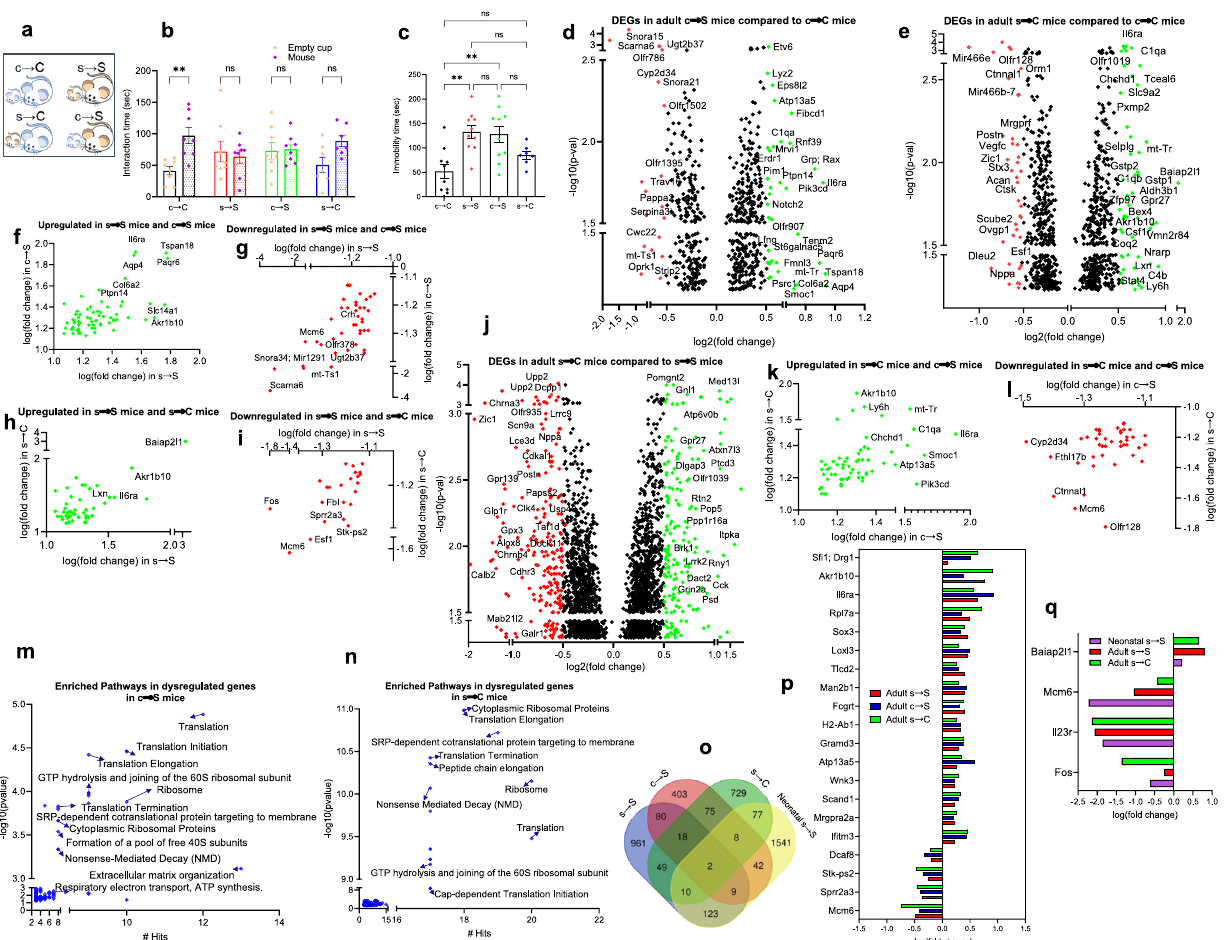
Fig. 4 Cross-fostering effects on behavioral phenotype and transcriptomic pro fi le. a Schematic of the Cross-fostering experiment design. b Time mice spent interacting with empty cup and unfamiliar mouse in the social interaction assay ( n = 8 c → C, 8s → S, 8 c → S, 7s → C). Two-way ANOVA: object effect ( F 1,54 = 7.255, P = 0.0094), exposure to stress effect ( F 3,54 = 0.1260, P = 0.9443), stressxobject interaction ( F 3,54 = 3.422, P = 0.0235) followed by Bonferroni post hoc test: empty cup vs unfamiliar mouse, ** P <0.01, ns not signi fi cant ( P >0.05). Data are presented as means±S.E.M. c Time mice spent immobile in the forced swim assay ( n = 10 c → C, 10s → S, 10 c → S, 7s → C). One way ANOVA revealed a signi fi cant stress effect ( F 3,33 = 7.531, P = 0.0006) followed by Tukey post hoc test: c → C vs s → S vs c → S, ** P <0.01, ns not signi fi cant ( P >0.05). d Volcano plot showing DEGs in brains from adult c → S versus c → C mice. e Volcano plot showing DEGs in brains from adult s → C versus c → C mice. f , g Volcano plot of genes showing similar direction of change in c → S and s → S: ( f ) upregulated and ( g ) downregulated genes. h , i Volcano plot of genes showing similar direction of change in s → C and s → S: ( h ) upregulated and ( i ) downregulated genes. j Volcano plot showing DEGs in brains from adult s → C versus s → S mice. k , l Volcano plot of genes showing similar direction of change in c → S and s → C mice: ( k ) downregulated and ( l ) upregulated genes. m , n Enriched biological pathways in the DEGs of ( g ) c → S and ( h ) s → C mice with number of genes ’ hits. Hypergeometric test, P <0.05. o Venn diagram showing the overlap of DEGs in all mouse groups. p Overlap of DEGs in adult mouse groups that received one hit of stress, prenatally only (s → C), postnatally only (c → S) or two hits of stress (s → S). q Overlap of DEGs in neonatal and adult mice that received one hit of stress prenatally with or without postnatal hit of